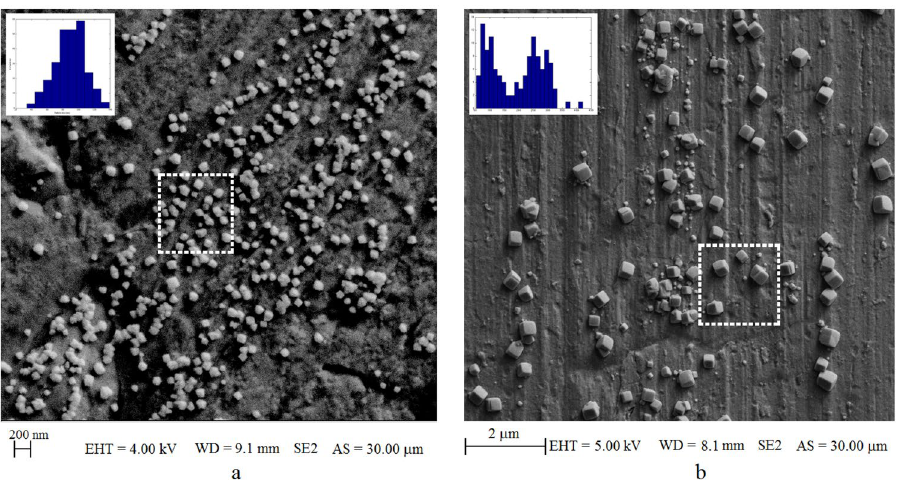
Figure 4. SEM images from anode surface for different electrolysis times when container was filled with 5 μ M RhB. ( a ) 90 seconds of electrolysis, the inset shows the histogram of nanoparticles in this image. The average is 100 nm and the nanocubes size range from 20 nm to 150 nm . ( b ) 5 minutes of electrolysis time. The inset shows the nanoparticle distribution in this image. There are two peaks, first peak is centered around 100 nm , and the second peak is centered around 300 nm , and nanocubes size range from 50 nm to 400 nm . The nanoparticles shown inside the dashed square regions are used in simulations for calculating the electric field distributions and the surface plasmon resonances (see